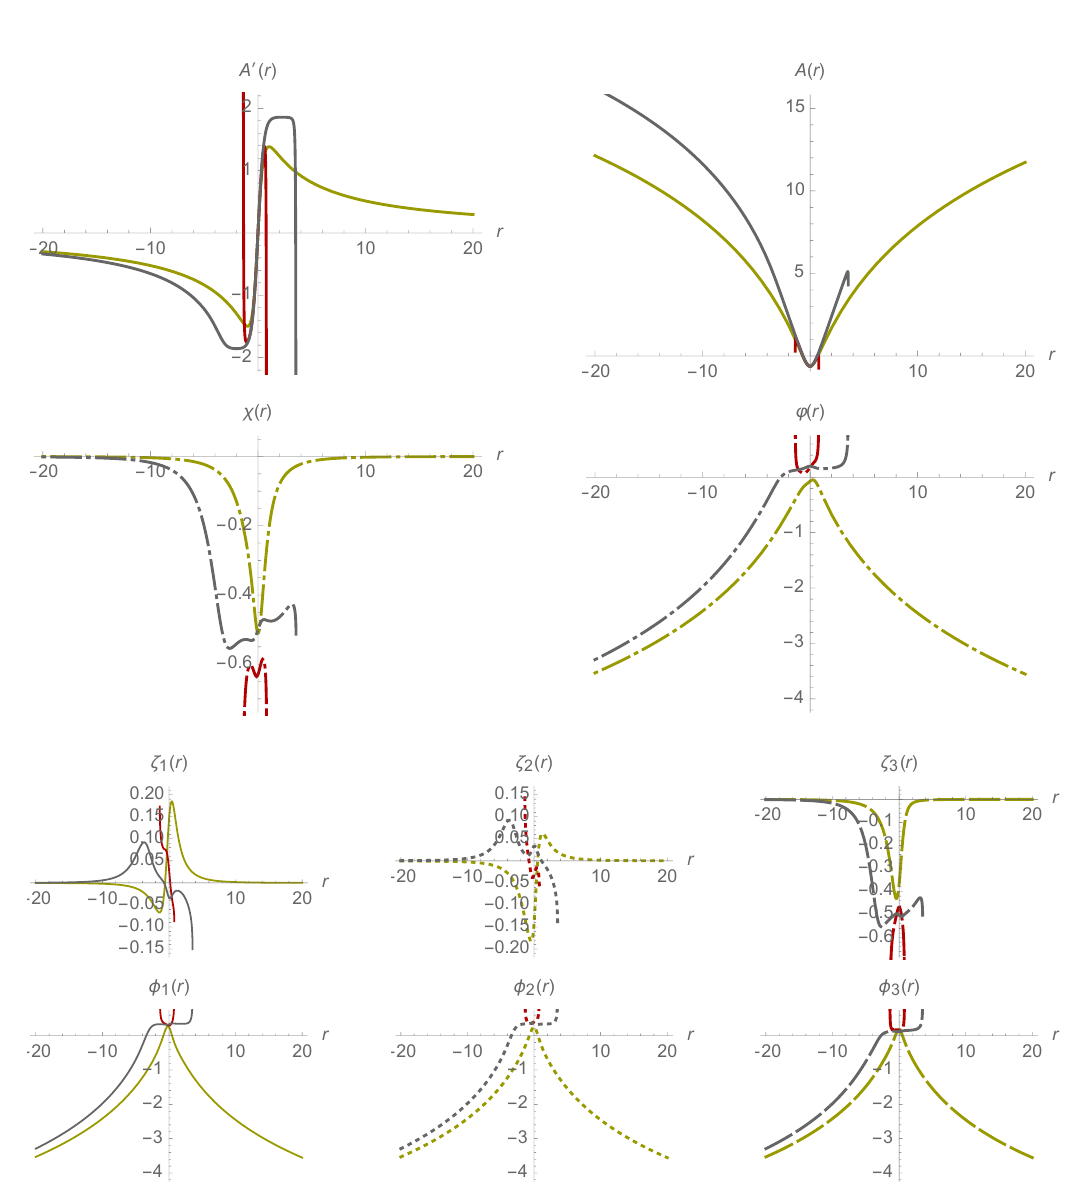
Figure 19. SYM/SYM (yellow), SYM/singularity (grey) and singular (dark red) N = 1 Janus solutions with SO(3)